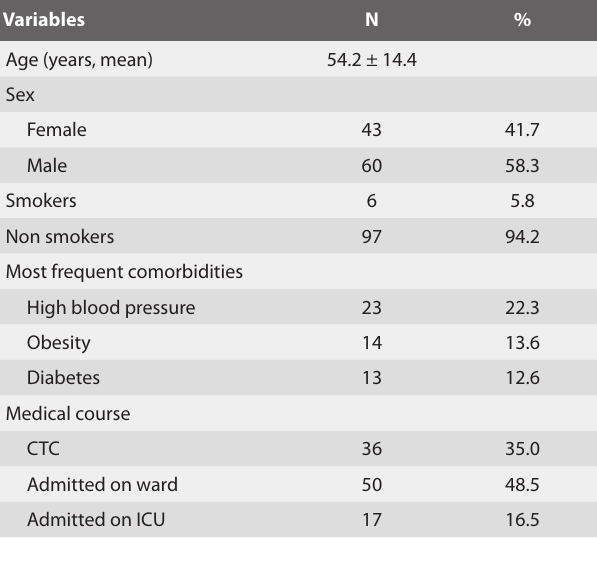
Table 1. Baseline patient